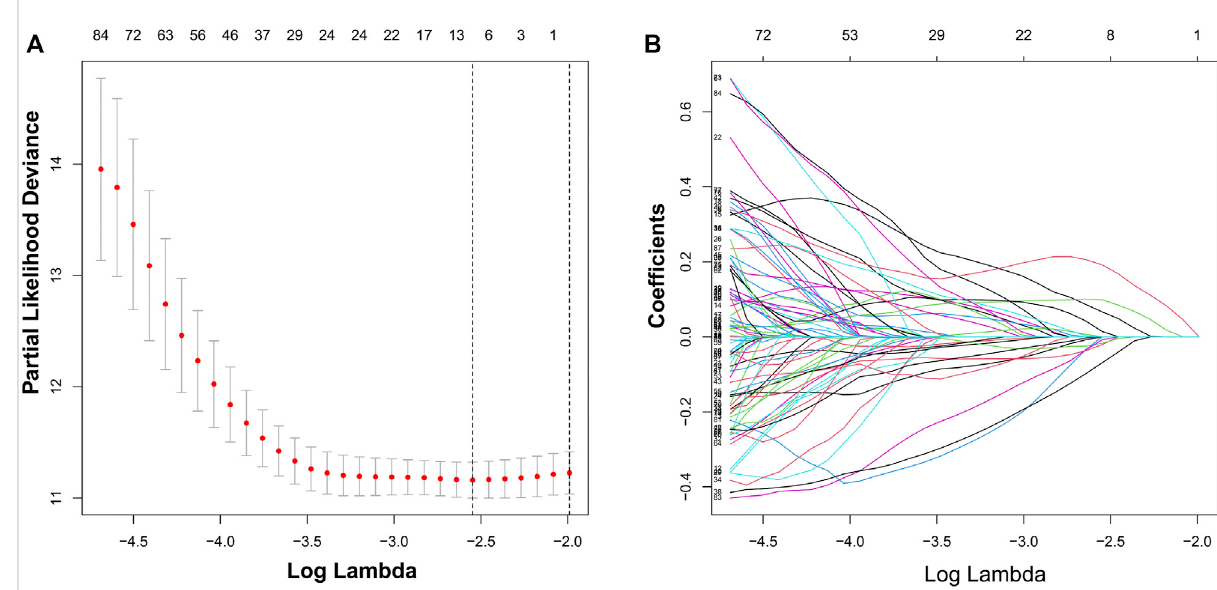
FIGURE 3 Identi fi cation of a risk signature by LASSO regression analysis. (A) , Cross-validation for tuning parameter selection in the proportional hazards model. (B) , LASSO coef fi cient spectrum of seven